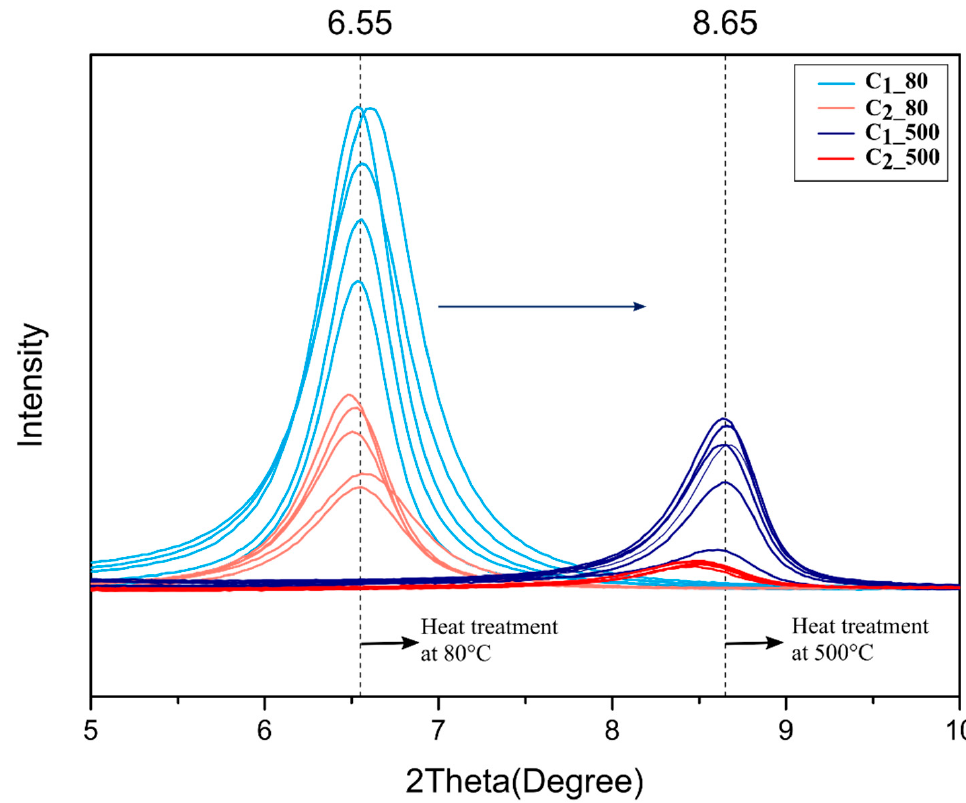
Figure 7. XRD patterns of samples heat-treated at different conditions. An interval from 5 ◦ to 10 ◦